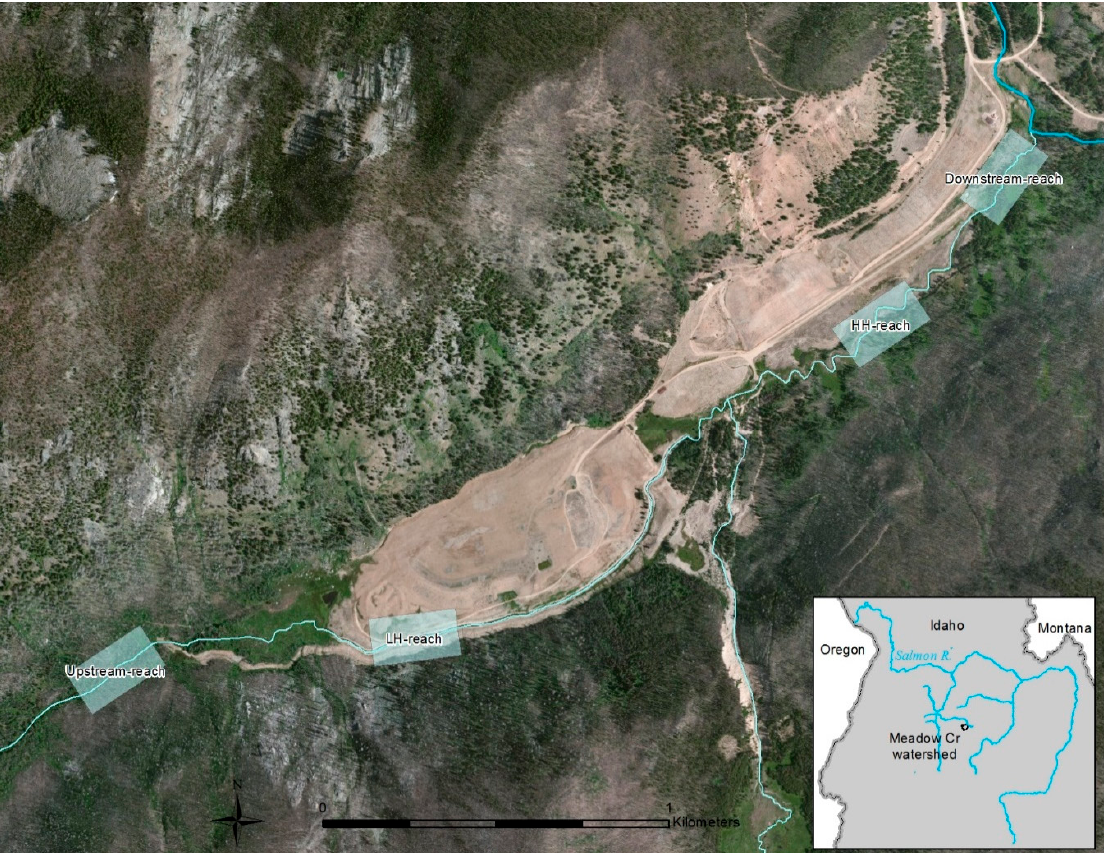
Figure 1. Stibnite Mine site, with Meadow Creek flowing northeast into the East Fork of the South Fork Salmon River (at top right). Over 3.2 km of mine tailings extend from the low habitat heterogeneity (LH-reach) through the high habitat heterogeneity (HH-reach). Boxes indicate 250 m study reaches. Inset shows the Meadow Creek watershed and its location in the headwaters of the Salmon River system in central Idaho, an area designated as critical habitat for three salmonid fish species listed as Threatened under the Endangered Species Act.